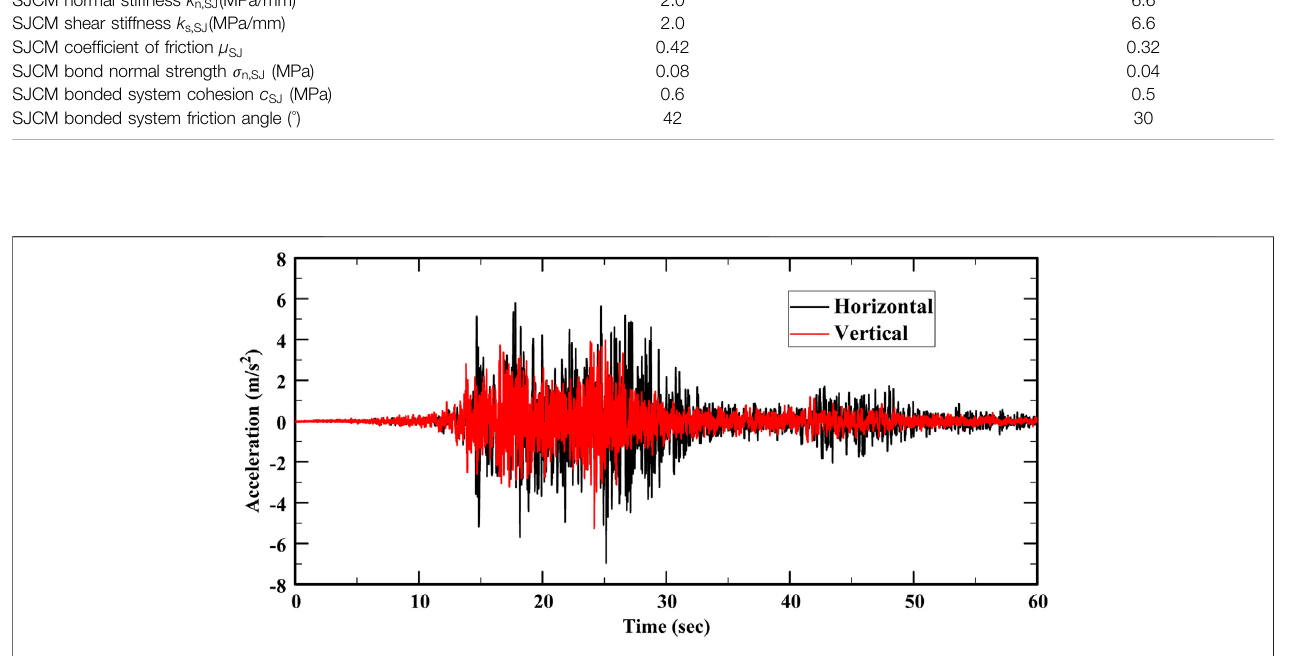
FFD-I and FFD-II are located on the left of the main grid domain, and the soil columns FFD-III and FFD-IV are located on the right. Note that only a seismic P-wave is applied on the bottom boundaries of soil columns FFD-I and FFD-IV and that only a seismic S-wave is applied on the bottom boundaries of soil columns FFD-II and FFD-III, while seismic P- and S-waves are applied to the bottom boundary of the main grid domain.